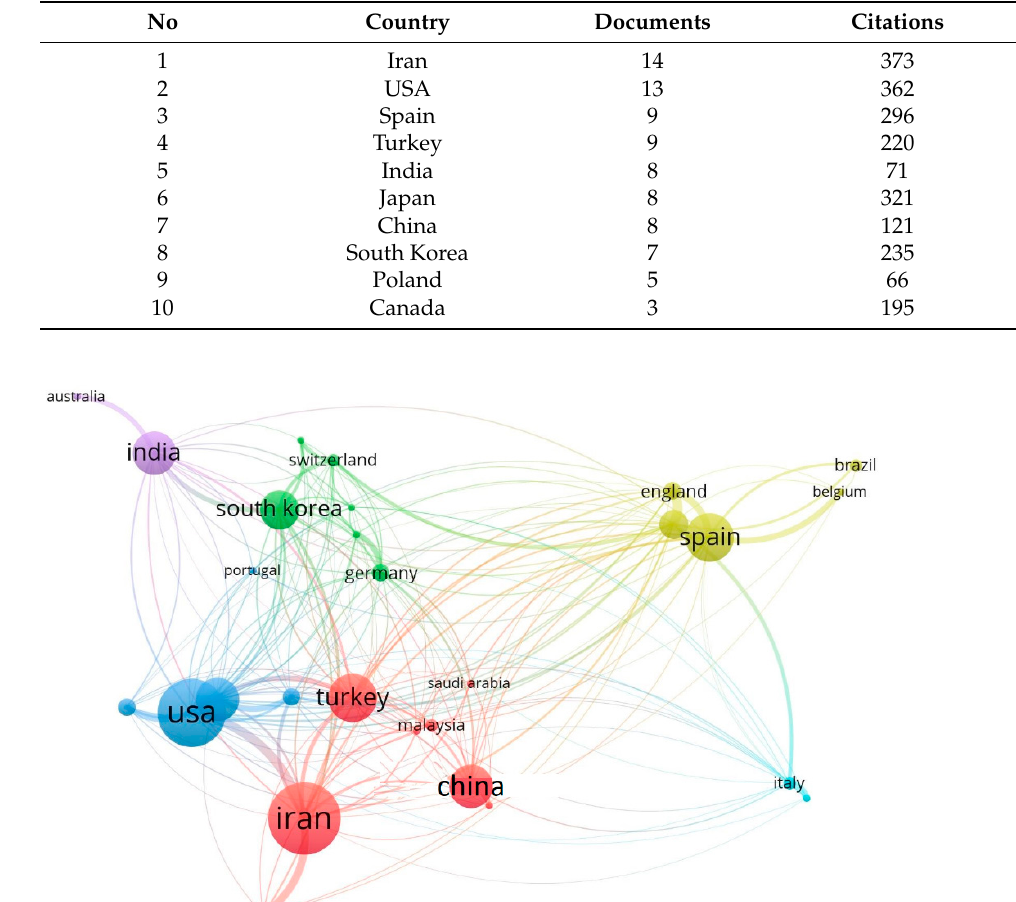
Table 11. Publications related to nanocomposites.